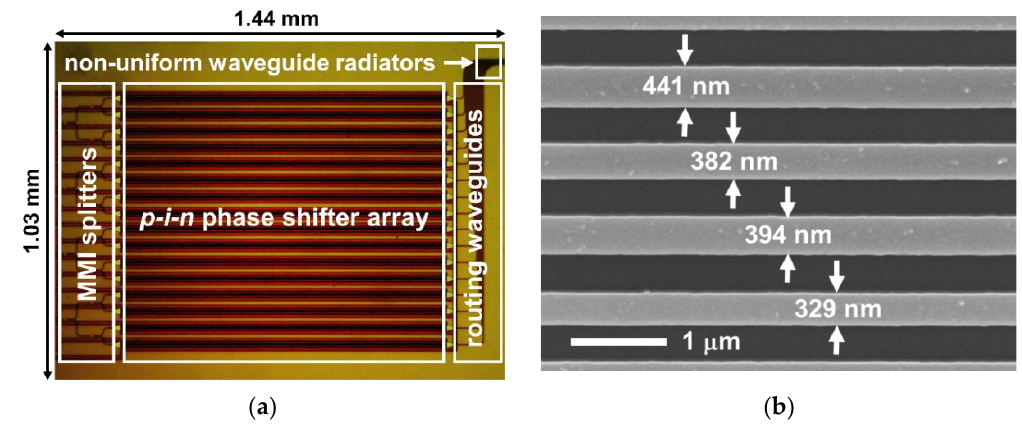
Figure 4. Fabricated device. ( a ) Optical microscope image of the OPA chip; ( b ) SEM image of the non-uniform waveguides in the radiator region.